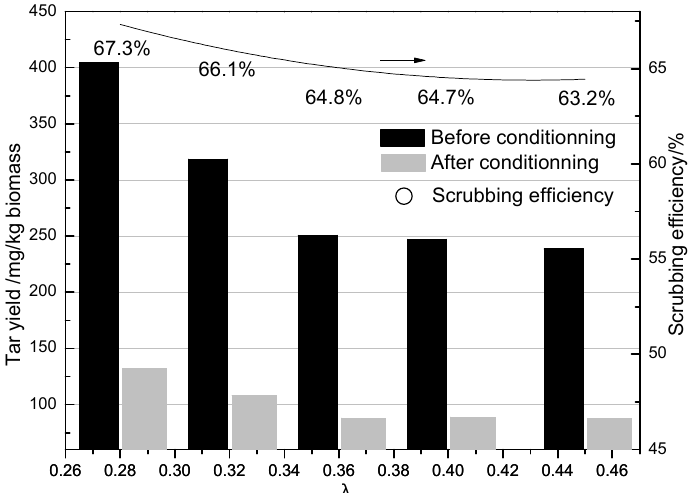
Figure 10. Tar concentration variation with λ .